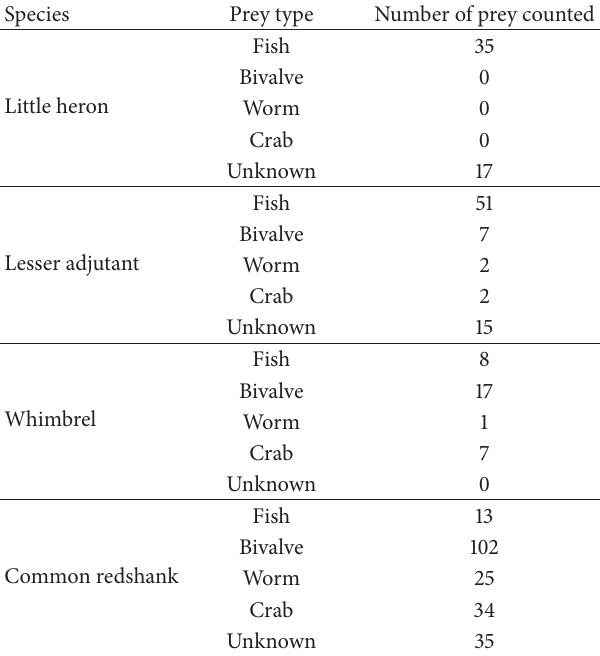
Table 4: Diet choice and abundance chosen by shorebird and water bird